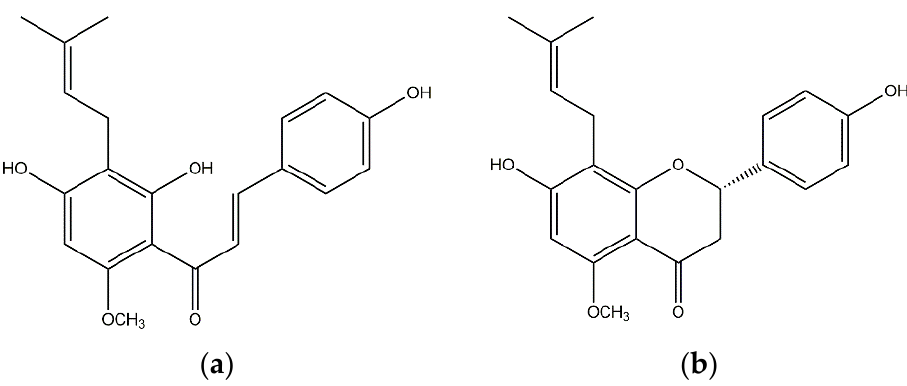
Figure 1. Structures of xanthohumol ( a, XN) and isoxanthohumol ( b , IXN).